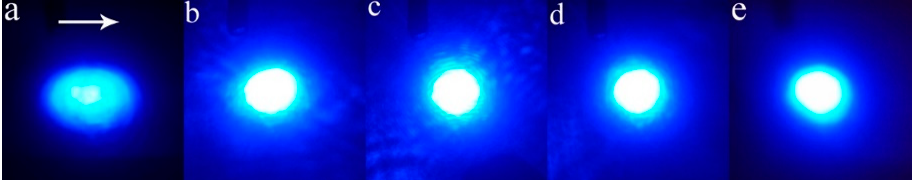
Figure 1. Distortion of transmitted laser beam spots after 5 min of irradiation. The white arrow represents th e c ‐ axis of the crystal. ( a ) LN:Mg 5.0 ; ( b ) LN:Mg 5.0 ,Zr 0.5 ; ( c ) LN:Mg 5.0 ,Zr 1.0 ; ( d ) LN:Mg 5.0 ,Zr 1.5 ; ( e ) LN:Zr 2.0 . The light intensities are ( a ) 2.8 × 10 3 W/cm 2 and ( b – e ) 2.2 × 10 5 W/cm 2 .